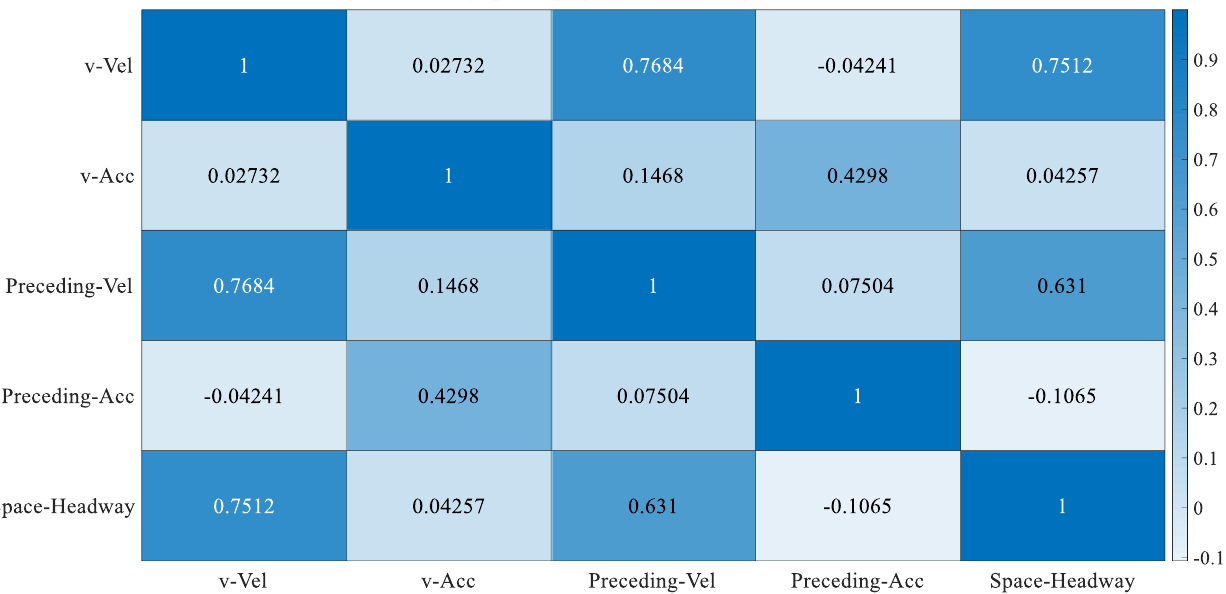
Figure 4. Kendall coefficient analysis results.